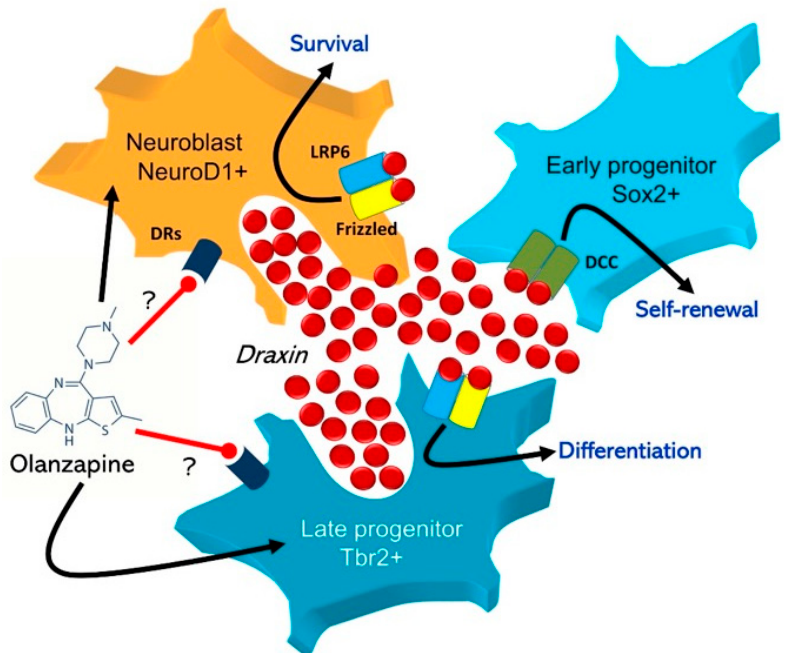
Figure 2. Hypothetical mechanism of possible olanzapine effect on draxin-releasing cells in the hippocampal stem cell niche. Expression and TUC4/NeuroD1-positive neuroblasts are considered as the main source of draxin in the dentate gyrus. Draxin secreted into the intercellular environment binds to membrane LRP6/Frizzled receptors of both aforementioned cells, and to DCC receptors of Sox2/nestin expressing early progenitors that support their proliferation, differentiation, and self-renewal within the SGZ niche.